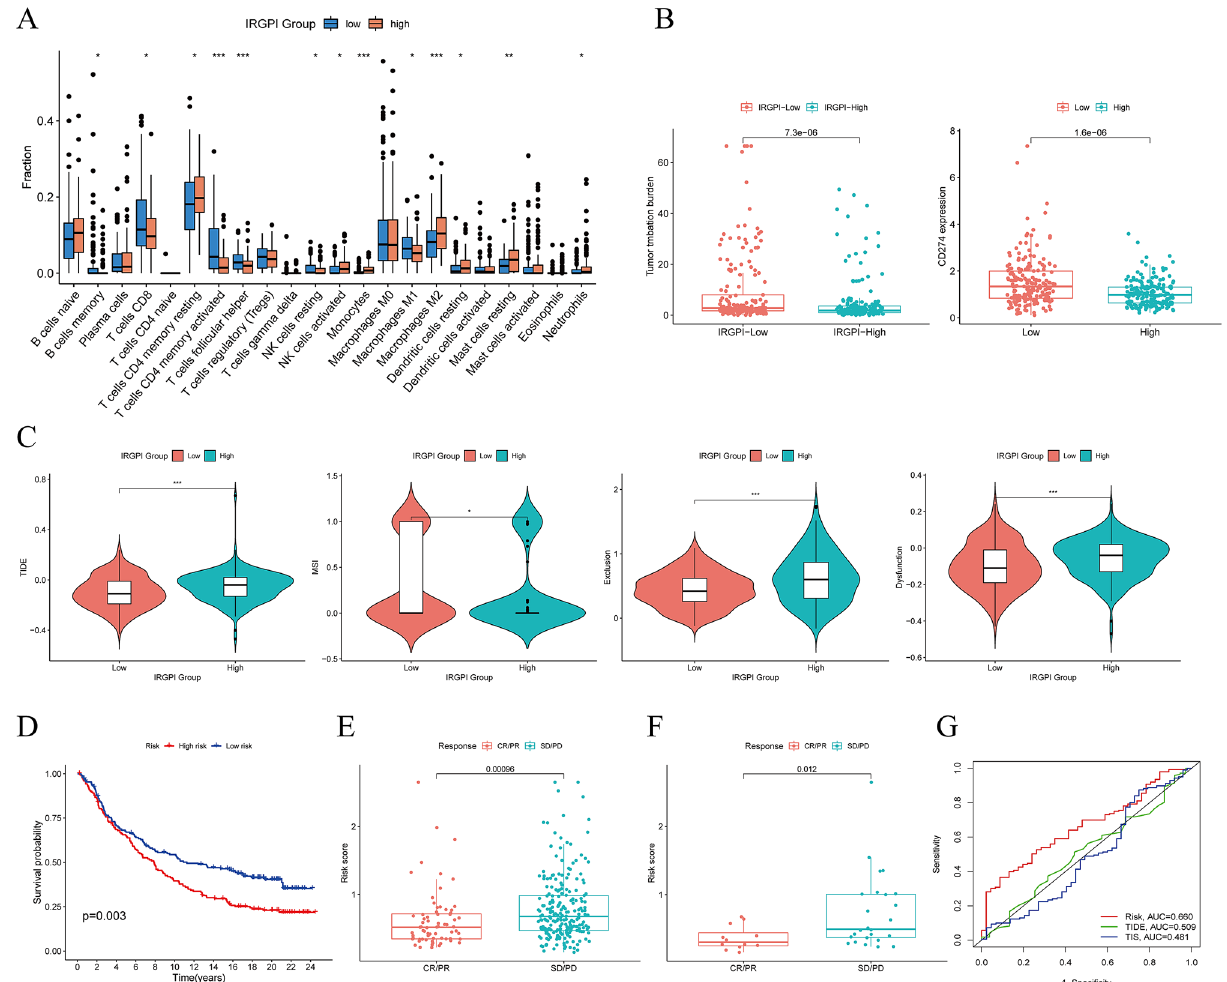
Figure 5. Prognostic value of IRGPI in immunotherapy. ( A ) The proportions of immune cells in different IRGPI groups. ( B ) Comparison of TMB and PD-L1 expression in different IRGPI groups. ( C ) TIDE, MSI, and T cell exclusion and dysfunction score in different IRGPI groups. ( D ) Kaplan–Meier survival analysis of the IRGPI groups in the IMvigor210 cohort. ( E ) IMvigor210 cohort of CR/PR and SD/PD in different IRGPI groups. ( F ) PRJEB25780 cohort of CR/PR and SD/PD in different IRGPI groups. ( G ) ROC analysis of IRGPI, TIS, and TIDE on overall survival at 1-, 3-, and 5-years OS in TCGA-STAD cohort. [Figures created by R, version